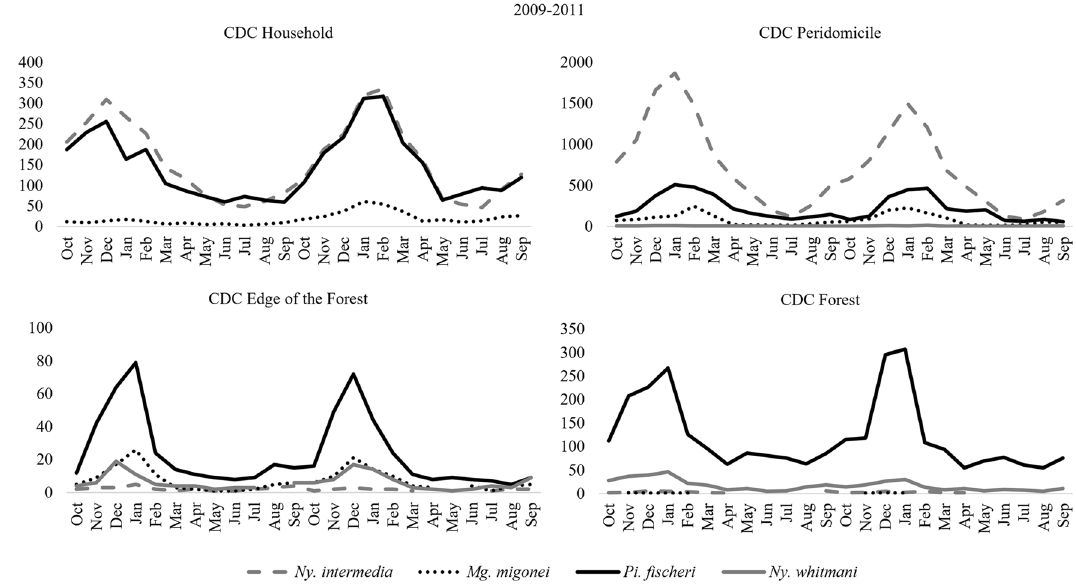
Figure 5. Monthly Frequency of Sand flies: Nyssomyia intermedia , Migonemyia migonei , Pintomyia fischeri and Nyssomyia whitmani , captured in the CDC light traps (household, peridomicile, edge of the forest and in the forest), from October 2009 to September 2011, in the neighborhoods of São Gonçalo, Municipality of Paraty, State of Rio de Janeiro,